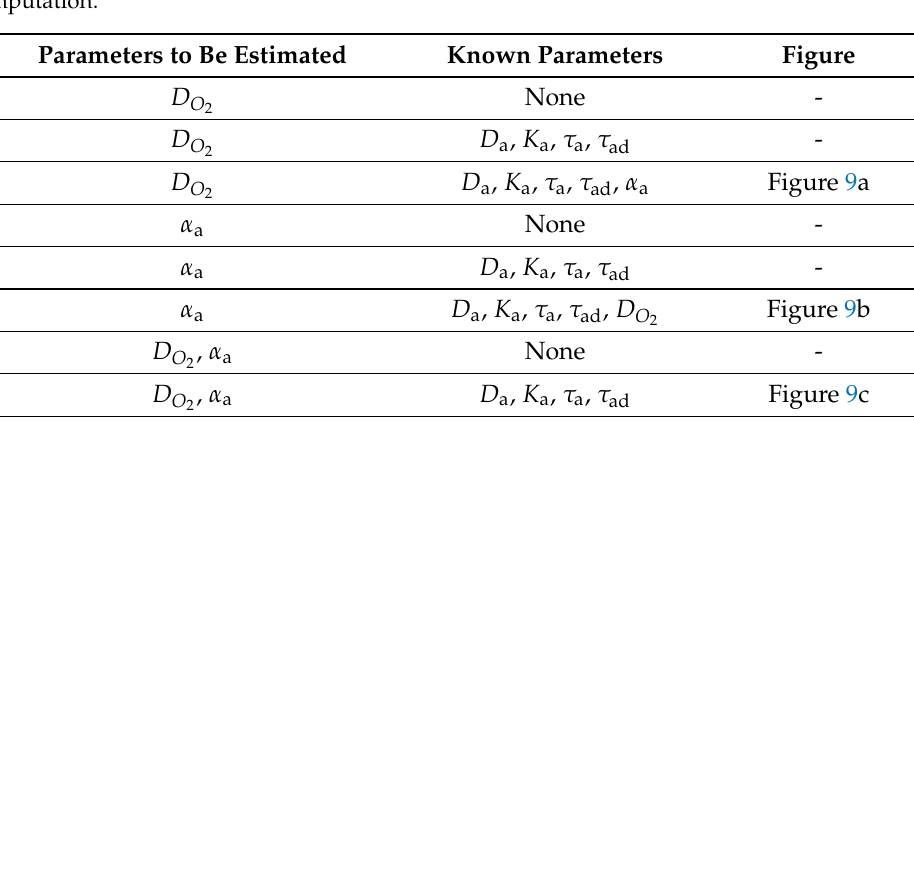
Table 3. Different possibilities when exploring the relationship between D O